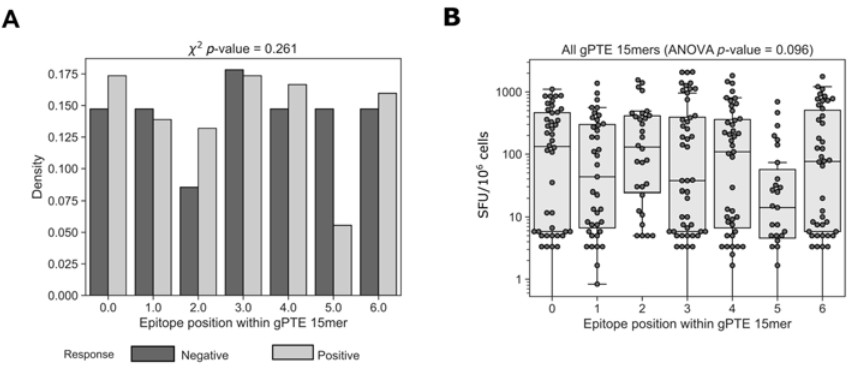
Figure 8. Accounting for responses missed by various peptide pools. Relative location of the determined epitopes was compared between positive and negative 15mer global peptides. Further analysis was also conducted on epitope location categorized response magnitudes. Peptides that were missed by one and not the other peptide sets were categorized according to the variance characterizing the AA overlap between the epitope and the negative or not tested (NT) peptide.